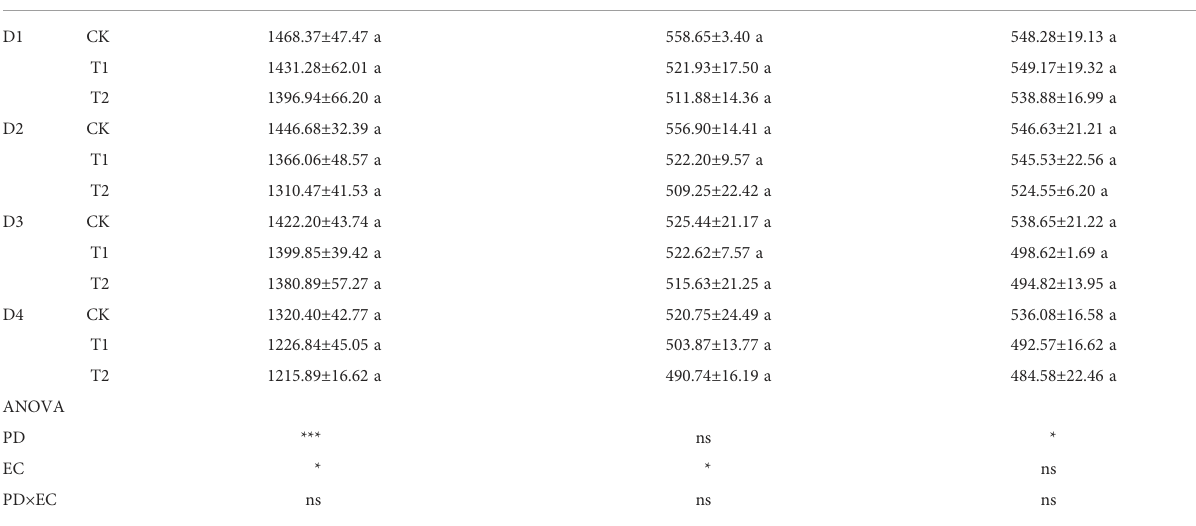
TABLE 4 Effects of EC and PD on cell wall acid invertase (CWIN), adenosine diphosphate pyrophosphorylase (AGPase), sucrose synthase decomposition direction (SuS) in grains of summer maize in 2021.